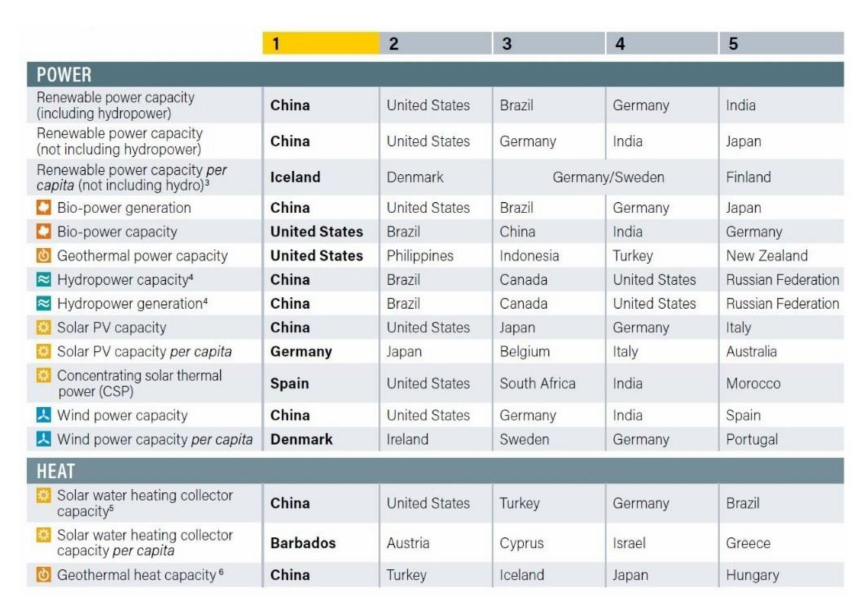
Figure 6. Country ranking on total renewable energy production capacity for 2017